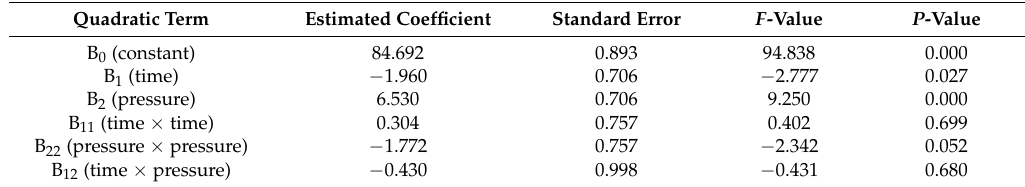
Table 4. Estimated quadratic equations coefficients for photocatalytic MG decolorization using plasma-treated immobilized TiO 2 photocatalyst and their respective F and P values.